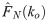
Block diagram of the iterative CFDL-MFP algorithm for N-step ahead force prediction.The block colors represent the time state for each iteration. Before iteration, the initial values of model input ΔUN(ko), PPD and output F^N(ko) are arbitrarily assigned. In the first iteration as k ← ko + 1, the initial values are used as current states (indicated by dotted arrows) to obtain the forecast for future states k + 1 (green arrows). In the next iteration with k ← k + 1, estimates from ko + 1 become the previous estimates (blue arrows), and estimates from k + 1 become current estimates. Solid black arrows represent transition from previous to current states.